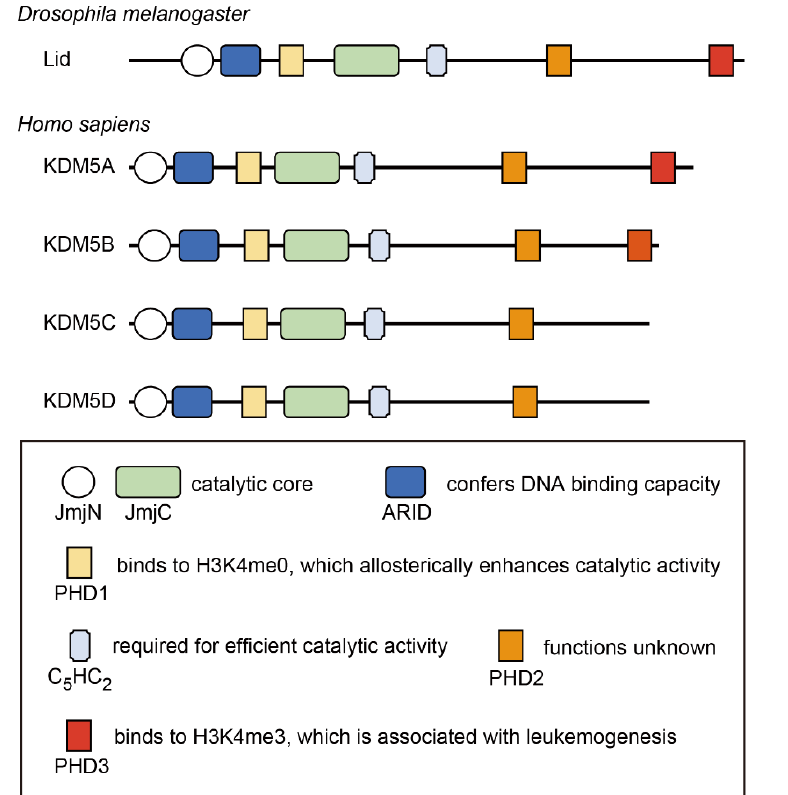
Figure 1. Domain structure of the KDM5 protein family. The functions of each domain are also presented. JmjN: Jumonji N domain; JmjC: Jumonji C domain; ARID: AT-rich interaction domain; PHD: plant homeodomain; C 2 HC 2 : C 5 HC 2 zinc finger. Table 1. Representative binding partners of KDM5 proteins.